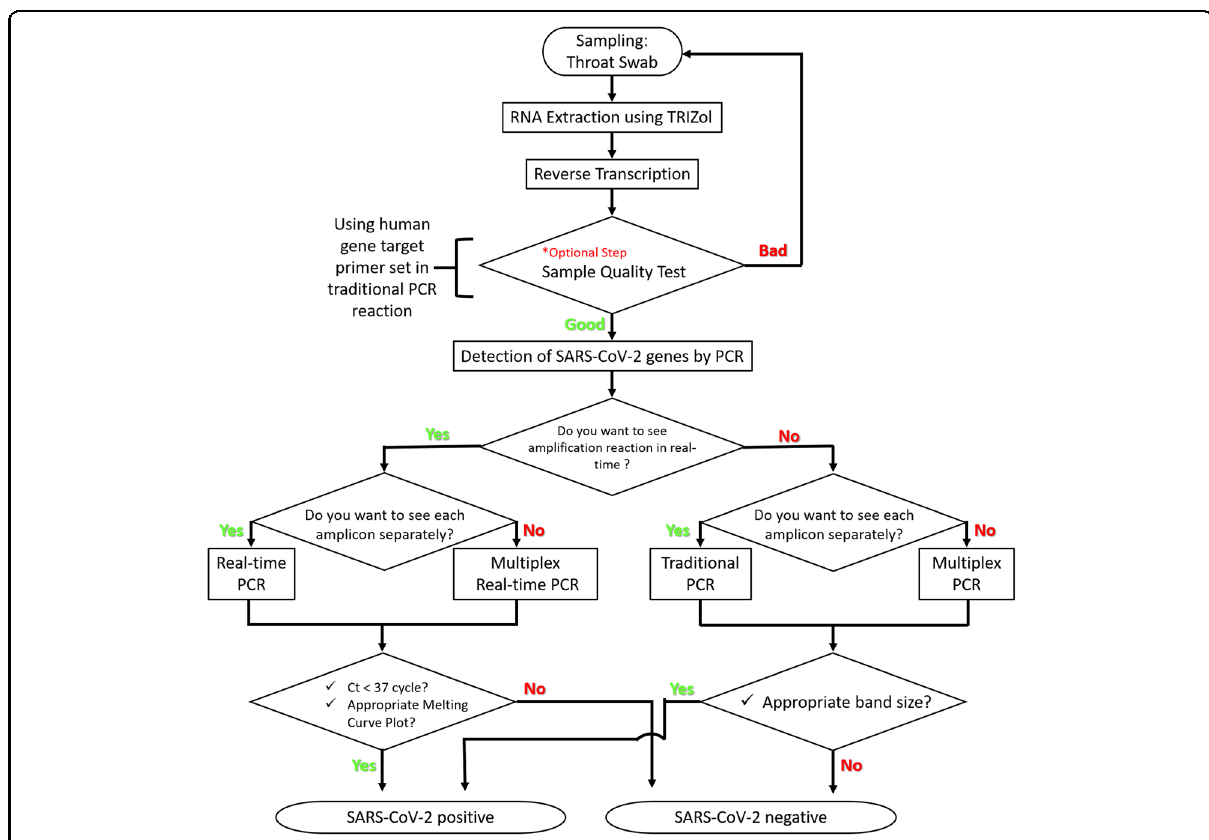
Fig. 7 Selection fl owchart for SARS-CoV-2 detection protocols. The fl owchart represents the sequence of steps and decisions required to perform SARS-CoV-2 detection. The oval symbols indicate the beginning and end of a program or sub-process. The arrows are the way the logic fl ows. The rectangle symbols represent a set of operations that changes the value, form, or location of data. The diamond symbols show a conditional operation that determines which one of the two paths the program will take. The red asterisk represents an optional sample-quality test